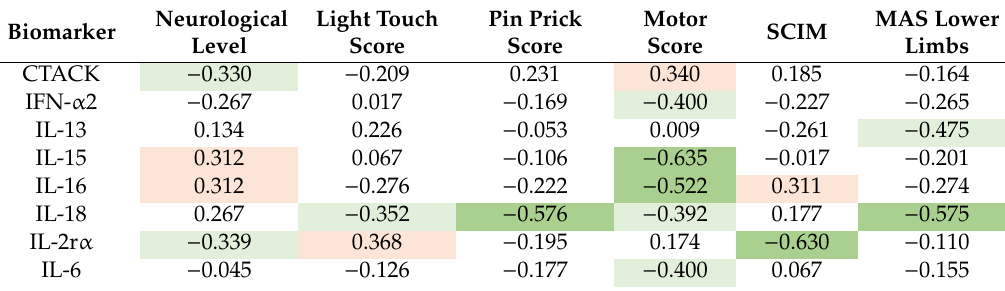
Table 4. Spearman’s correlation coe ffi cients between biomarkers and changes in scale scores between baseline and discharge. The heat map is in red for positive correlations and green for negative correlations. The color saturation is proportional to the strength of associations between